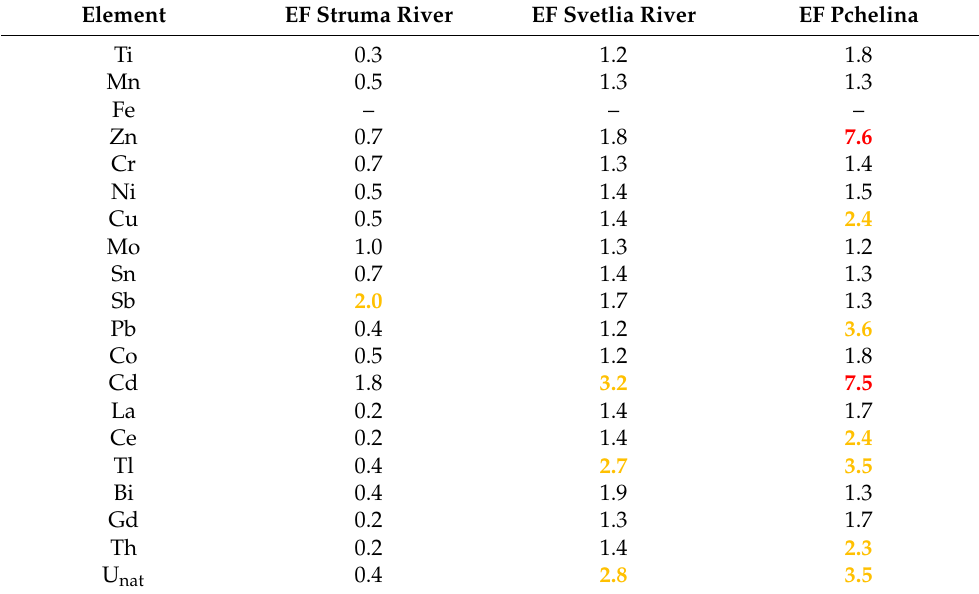
Table 2. Enrichment factor (EF) in the three sampling points (yellow—moderate enrichment, red— significant